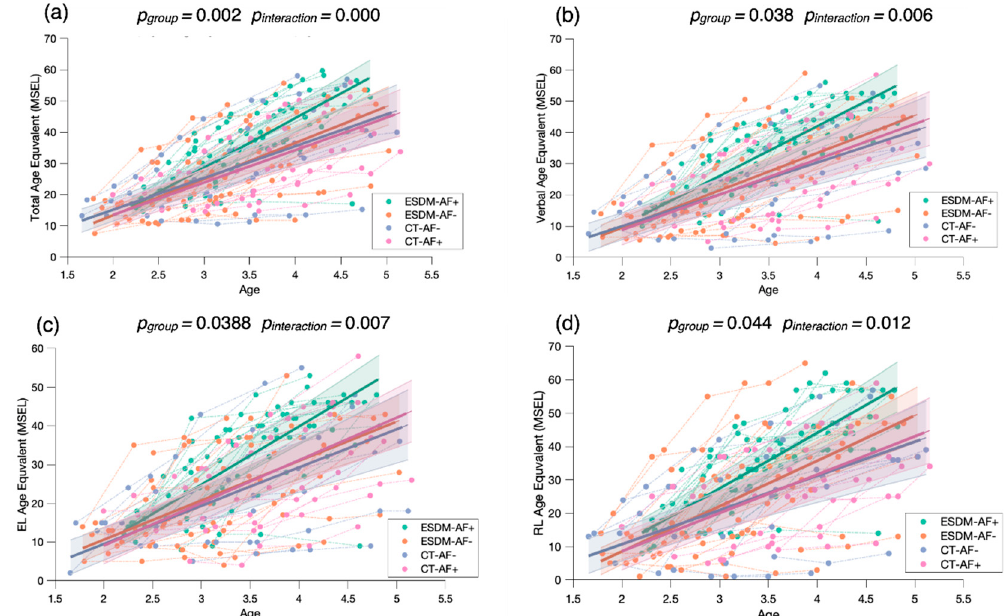
Figure 6. Mixed model regression analysis for the MSEL Total Age Equivalent ( a ), Verbal Age Equivalent ( b ), Expressive Language Age Equivalent ( c ), and Receptive Language Age Equivalent ( d ) for 265 longitudinal recordings from 81 young children with ASD (2.78 ± 0.65 years old) with lower or higher social orienting at baseline and who either received an early and intensive intervention ( ESDM-AF+; ESDM-AF- ) or community treatment ( CT-AF +; CT-AF- ). The group-level trajectory (bold line) is derived from mixed-effect modeling [43–45]. The 95% confidence interval is indicated by the colored bands around the estimated group-level trajectory.